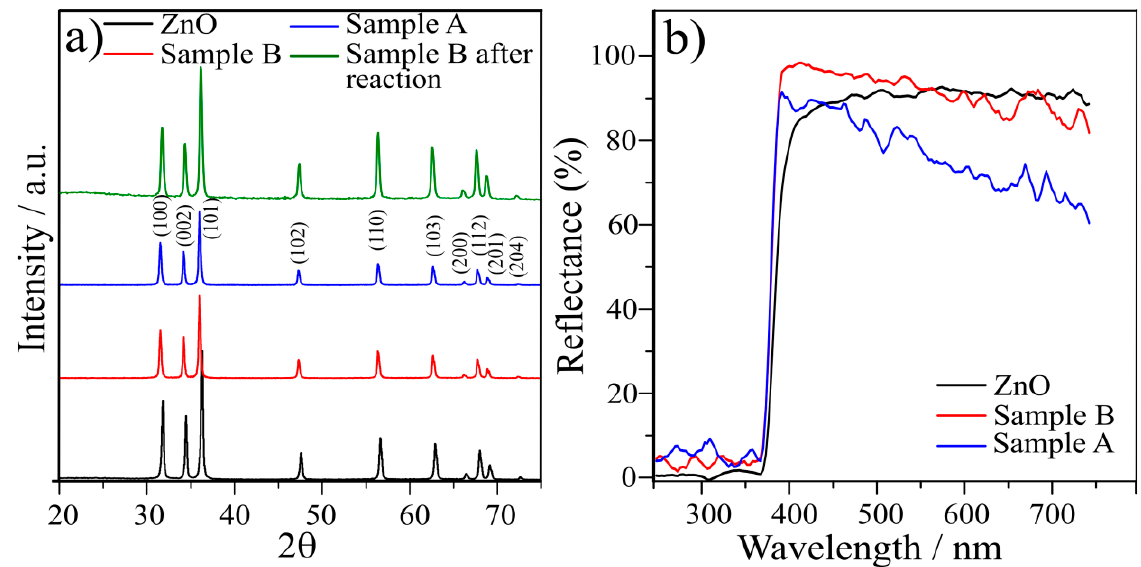
Figure 1. ( a ) XRD patterns and ( b ) diffuse reflectance UV–vis spectra of the photocatalysts.